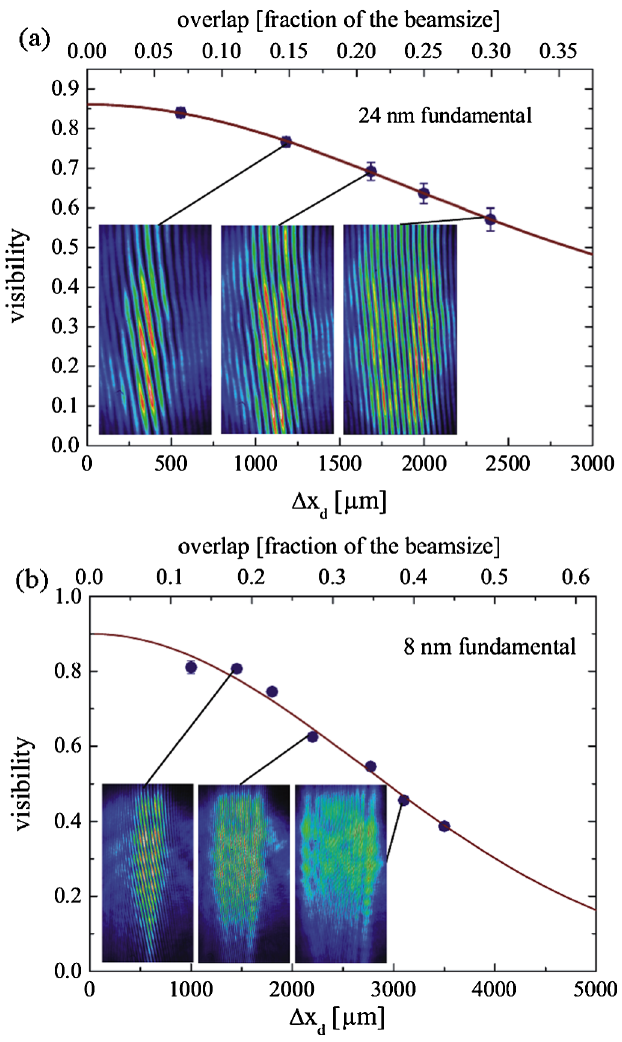
FIG. 7. Spatial coherence at (a) 24 nm and (b) 8 nm funda- mental wavelength. The insets show typical single shot interfer- ence pattern at different overlaps. The solid line is a Gaussian fit.